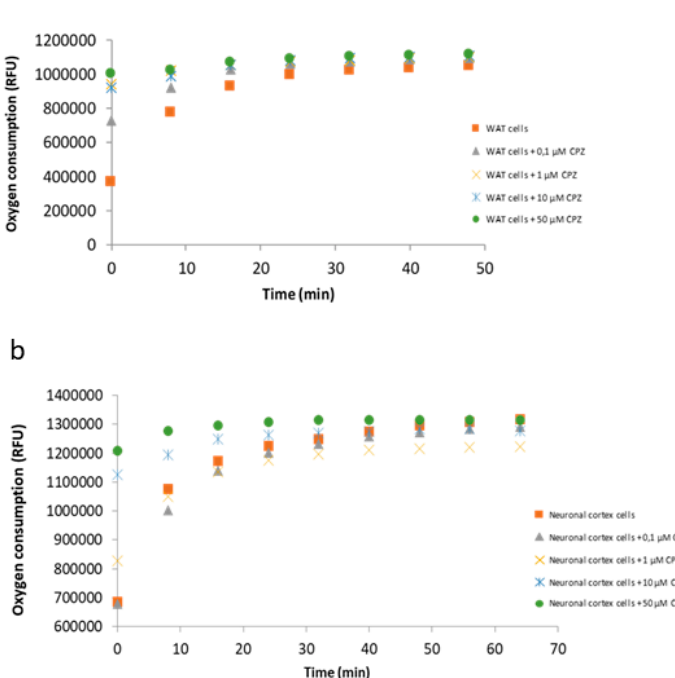
Figure 8. OCR assay in white adipose tissue (WAT) ( a ) and cortical neurons ( b ) incubated with increasing concentrations of CPZ (0.1–50 µ M) for 24 h. Oxygen consumption was monitored in real-time using 96-well plate oxygen-sensing plates. Data are the mean ± S.E.M of five independent experiments. RFU: relative fluorescence units.